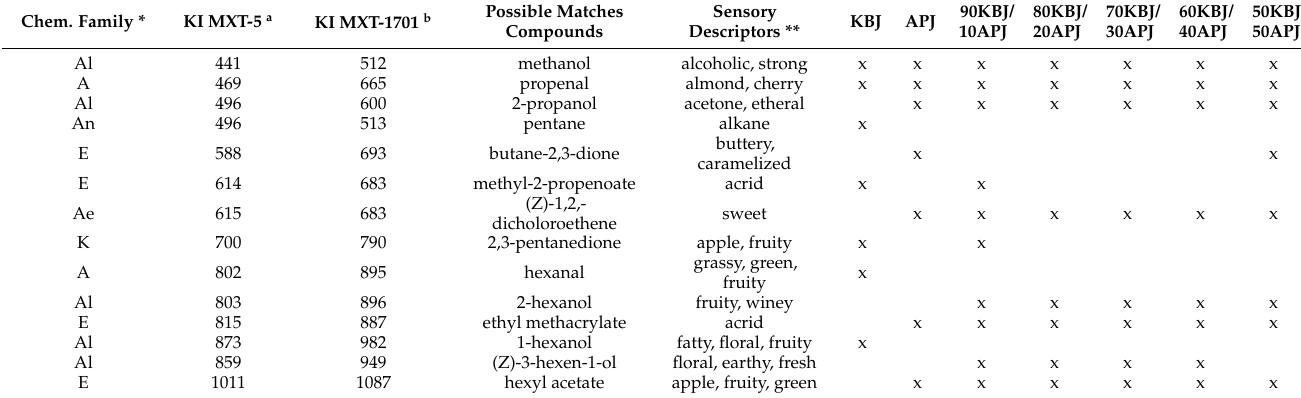
* (A)—aldehyde, (Al)—alcohol, (E)—ester, (K)—ketone, (An)—alkane; ** The sensory descriptions for the listed compounds are taken from AroChemBase; a Kovats index for non-polar column; b Kovats index for slightly polar